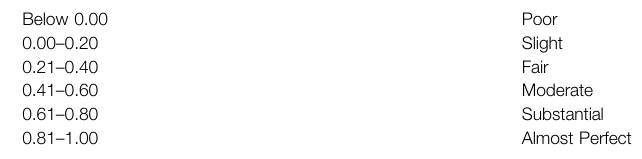
TABLE 1 | De fi nition of the Eftedal and Brubakk venous gas emboli (VGE) grading used in echocardiography analysis, adapted from (Eftedal et al., 2007). The third column shows the binary classi fi cation based on VGE presence.